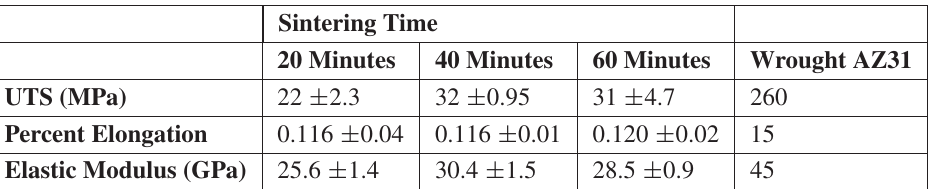
Table 3. Tensile results of P/M AZ31 alloy. Compaction pressure of 500 MPa, sintering temperature of 500 °C and 450 °C quench temperature. Data for wrought AZ31 alloy for comparison